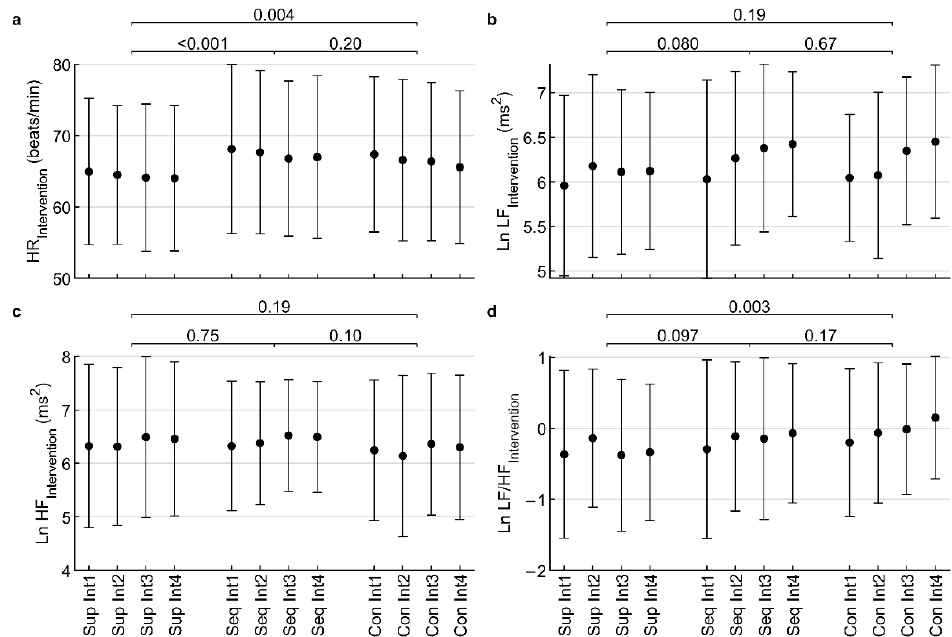
Figure 5. Influence of low-frequency sound on heart rate ( a ); low-frequency power ( b ); high-frequency power ( c ); and low-frequency/high-frequency ratio ( d ) during intervention lasting 4 × 5 min (Int1 to Int4). Ln—natural logarithm; Sup—placebo supine; Seq—stimulation with amplitude LFV; Con—constant LFV. The values displayed above the clips are p -values of ANOVA contrasts.